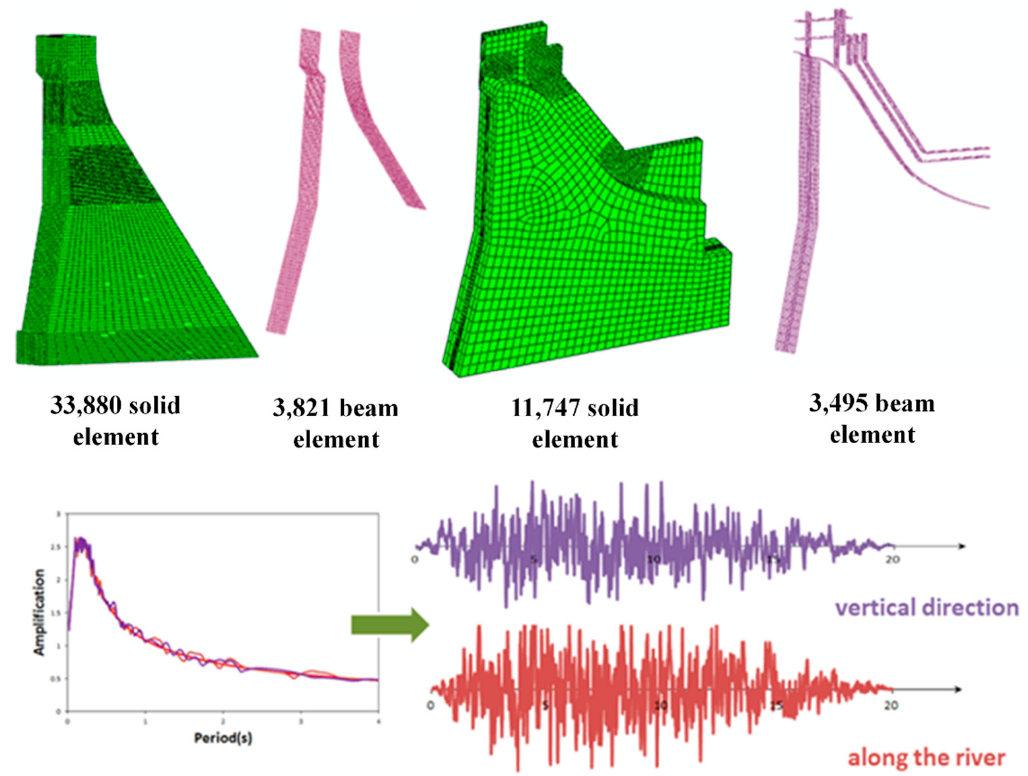
Figure 10. The element model of the Huangdeng gravity dam.